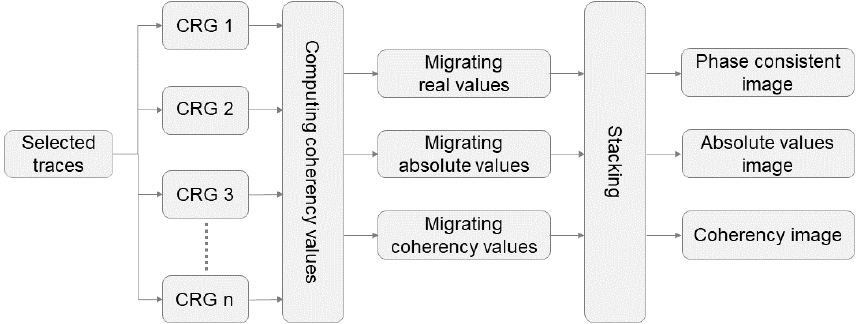
Figure 6. Schematic sketch of the imaging procedure.